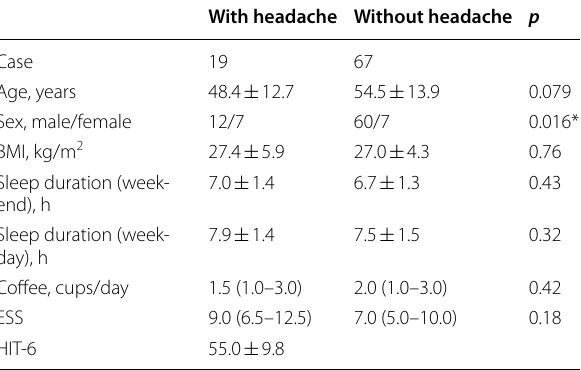
Table 1 Characteristics of sleep apnea patients with and